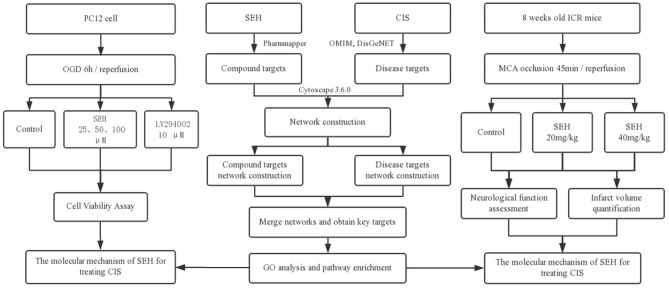
The flowchart of this study based on an integration strategy of network pharmacology and experimental verification for deciphering pharmacological mechanisms of SEH acting on CIS. SEH, senkyunolide-H; CIS, cerebral ischemic stroke; OMIM, Online Mendelian Inheritance in Man; DisGeNET, a database of gene-disease associations; OGD, oxygen-glucose deprivation; MCA, middle cerebral artery.